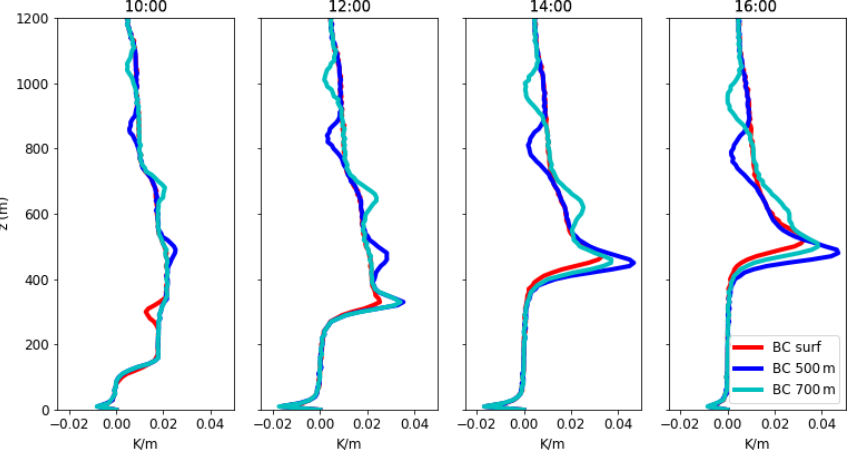
Figure 6. Potential temperature lapse rate for simulations on 3 December at 10:00, 12:00, 14:00 and 16:00 for Aero_load_BCsurf (red), Aero_load_BC500 (blue) and Aero_load_BC700 (cyan)